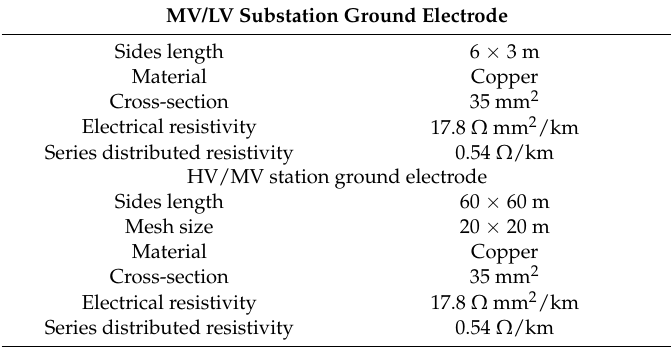
Table 1. Electrical and geometrical data of the ground electrodes for the two selected